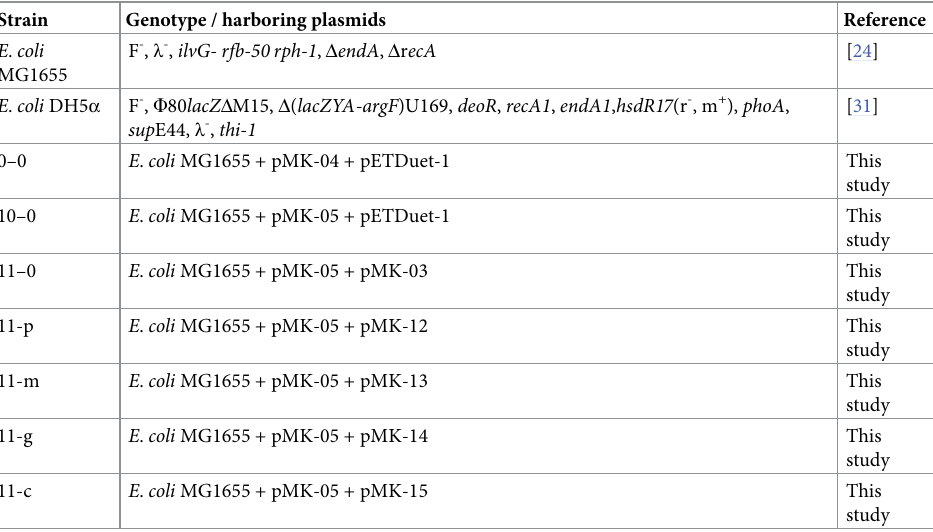
Table 2. Strains used in this